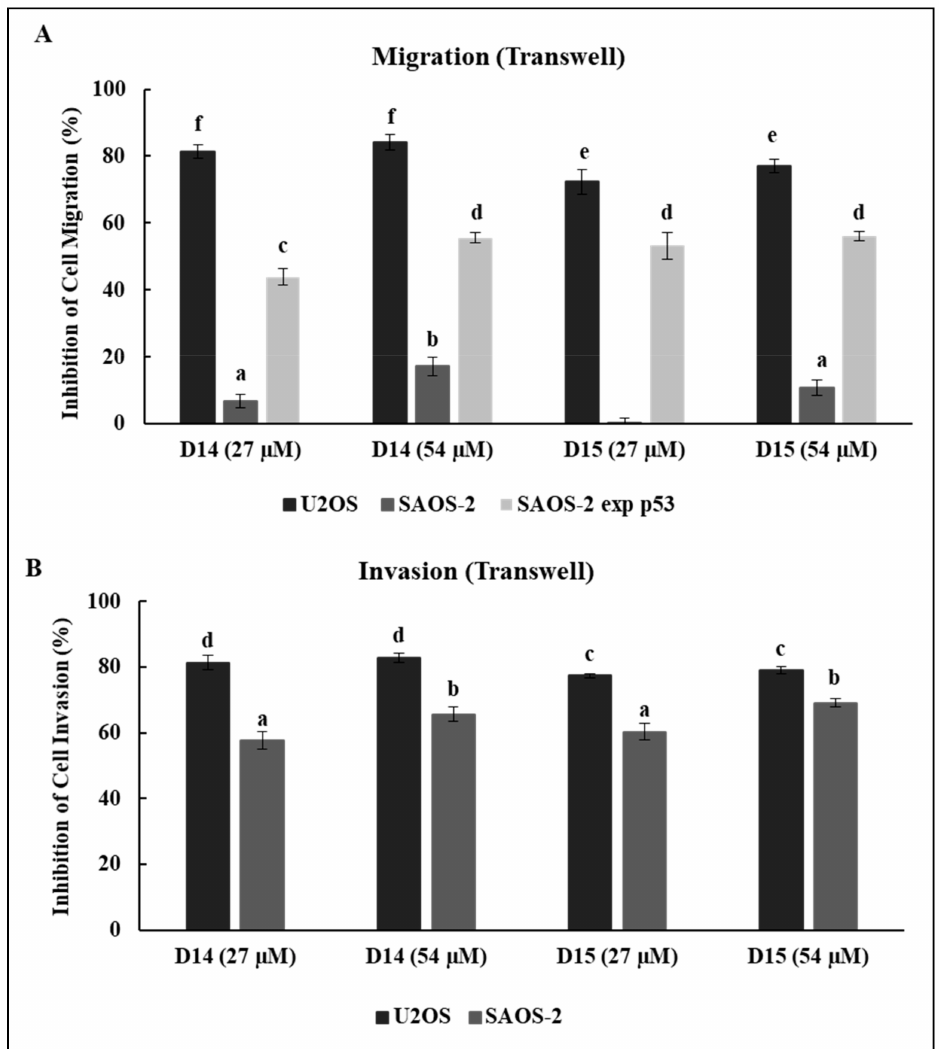
Figure 2. Effects of D14 and D15 on the migratory and invasive abilities of osteosarcoma cells. ( A ) Migration of osteosarcoma cells in Transwells. ( B ) Invasion of osteosarcoma cells in Transwells pre-coated with Matrigel. For migration and invasion, cells in serum-free medium were placed in the top chamber of the Transwell. Complete medium (10% serum) containing D14 and D15 at the indicated doses was added to the lower chamber. After 24 h, the cells that had migrated or invaded through the membrane were stained and quantified. The results are expressed as means ± standard deviation of three individual experiments. Means followed by the same letter are not significantly different ( p < 0.05) according to Tukey’s HSD